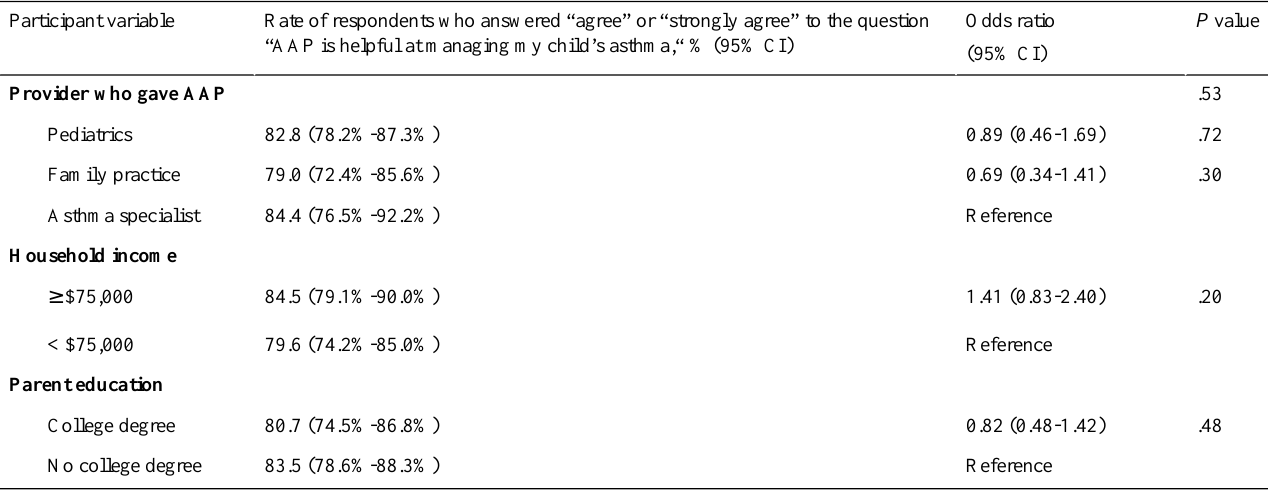
Table 3. Results of the logistic regression analysis for predicting whether an Asthma Action Plan (AAP) is helpful for managing asthma. CI)Rate of respondents who answered “agree” or “strongly agree” to the question CI)Participant “AAP is helpful at managing my child’s asthma,“ % (95%